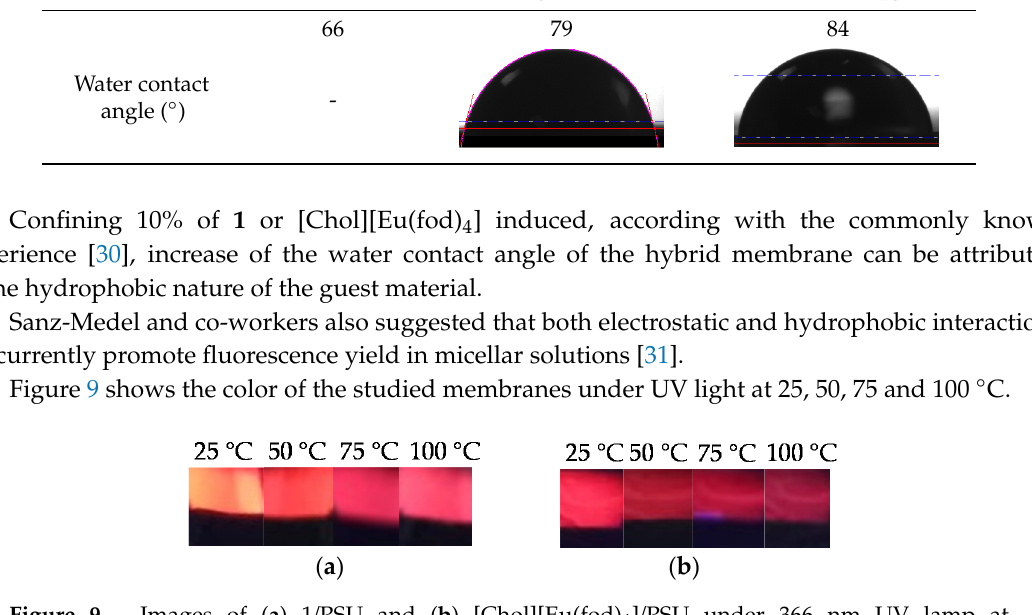
Figure 9. Images of ( a ) 1/PSU and ( b ) [Chol][Eu(fod) 4 ]/PSU under 366 nm UV lamp at different temperatures.